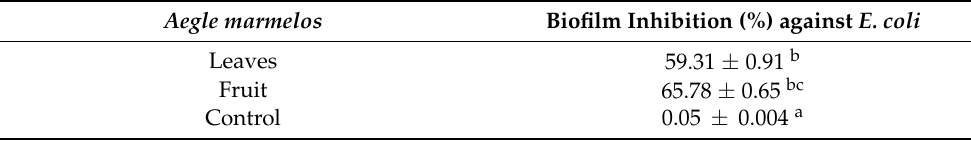
The values are reported as mean ± SEM values. Identical superscripts letters within rows indicate no significant difference ( p >